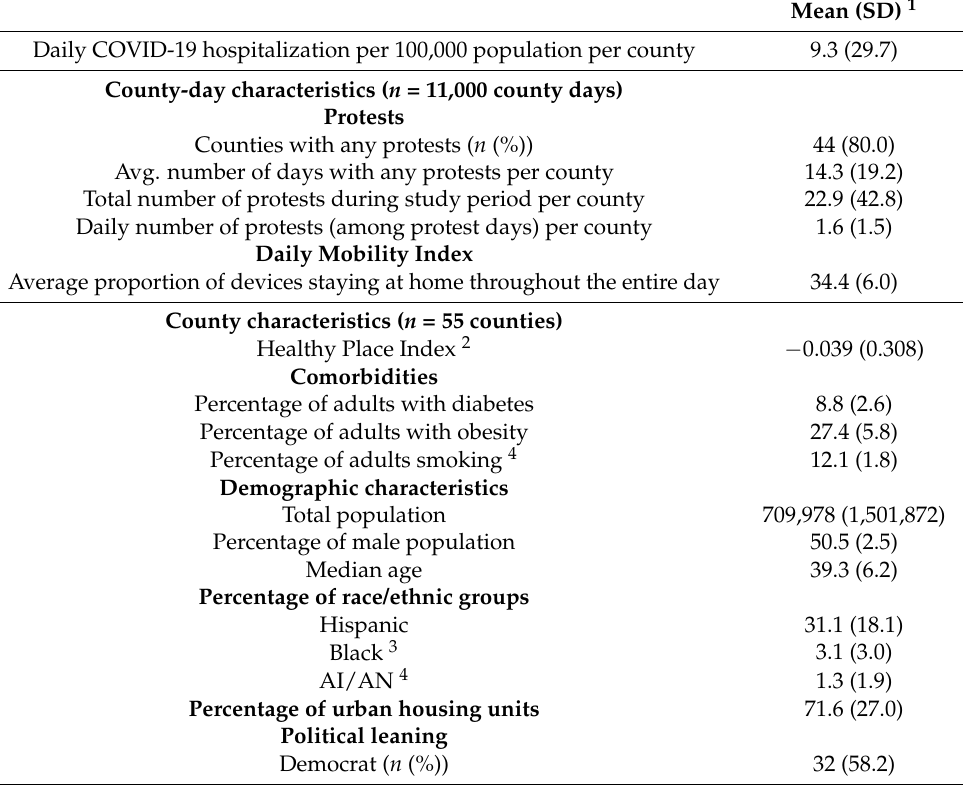
Table 1. COVID-19 hospitalization rate, protest data, and covariates for all counties and